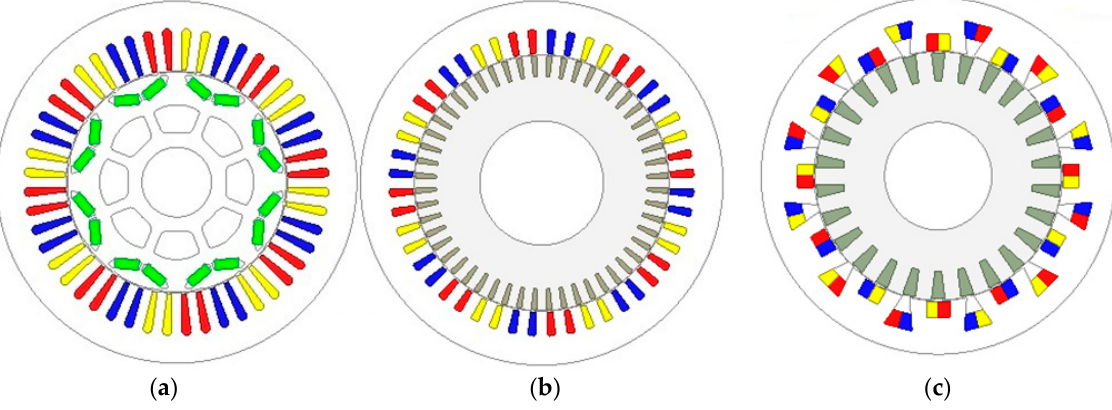
Figure 1. Two-dimensional views of the compared machines: ( a ) IPM (48S/16M/8P). ( b ) CIM (48S/52R/8P). ( c ) AIM (24S/26R/8P).